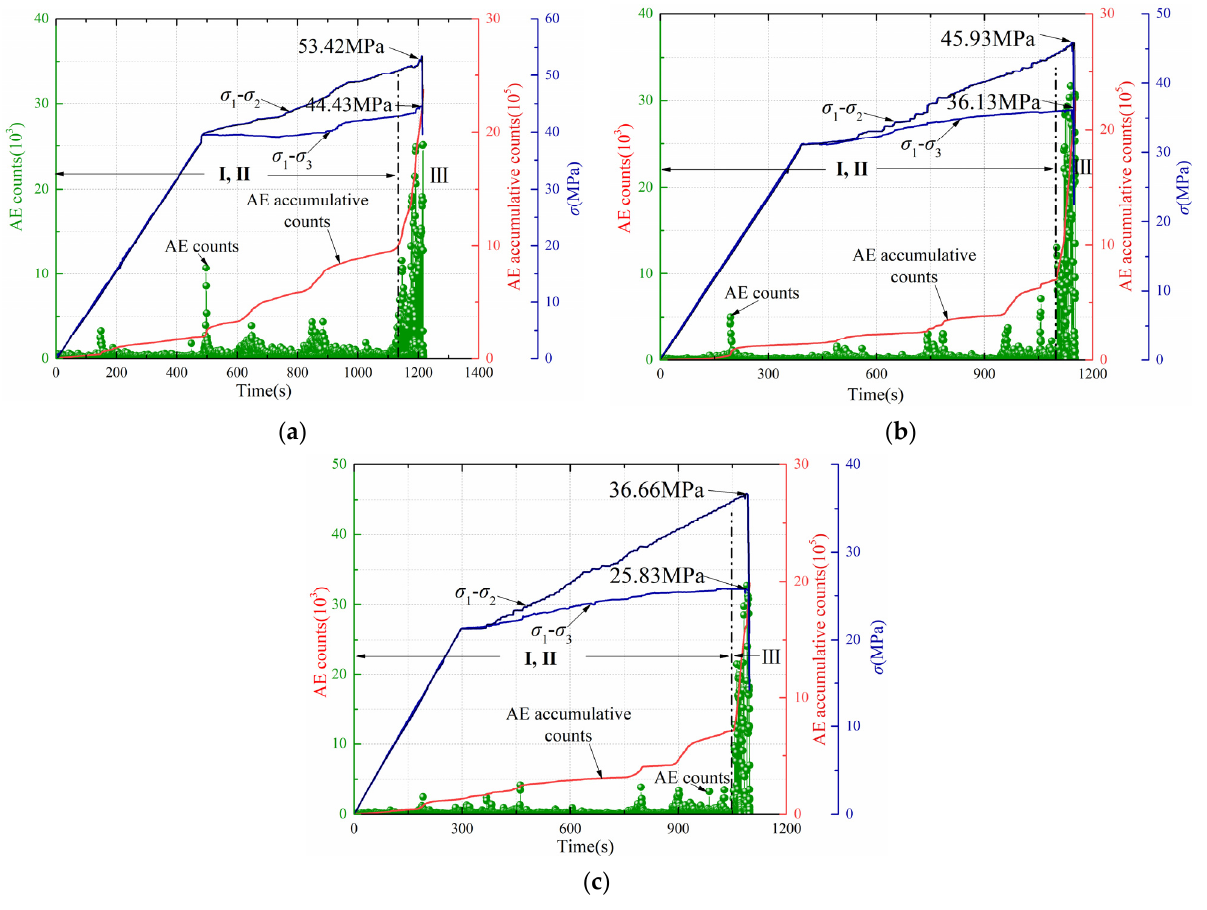
Figure 8. Acoustic emission response during the unloading test. ( a ) Gas pressure of 0.2 MPa. ( b ) Gas pressure of 0.5 MPa. ( c ) Gas pressure of 0.8 MPa.